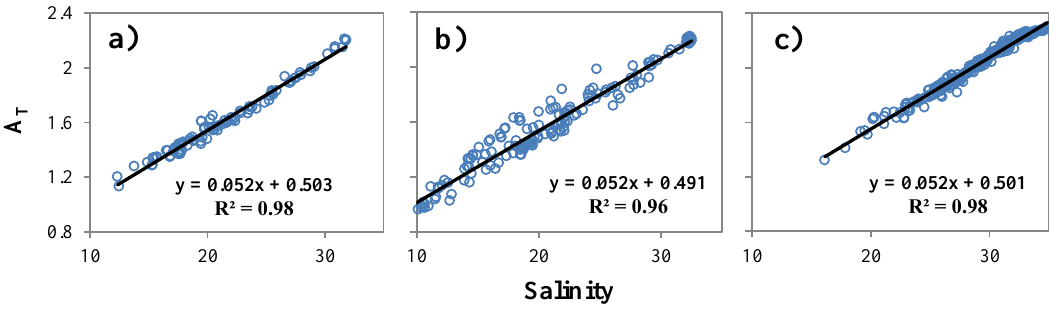
Fig. 10. Relationship between A T (mmolkg − 1 ) and salinity for samples collected in the ESS in September 2003 (a) , September 2004 (b) , and August–September 2008 (c)